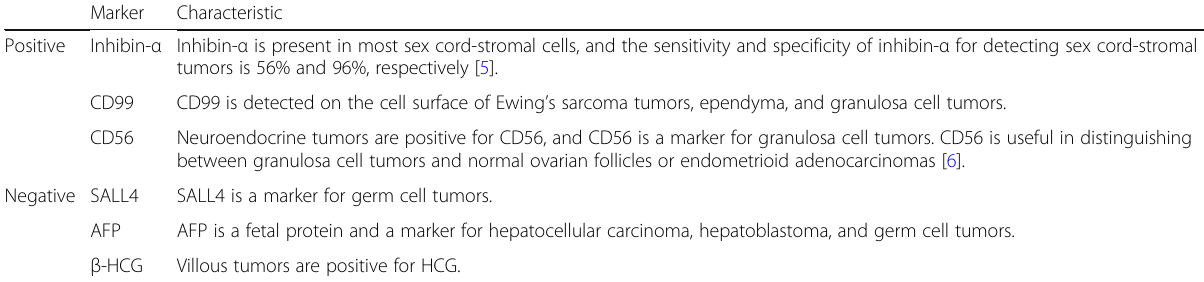
Table 1 Markers for immunostaining